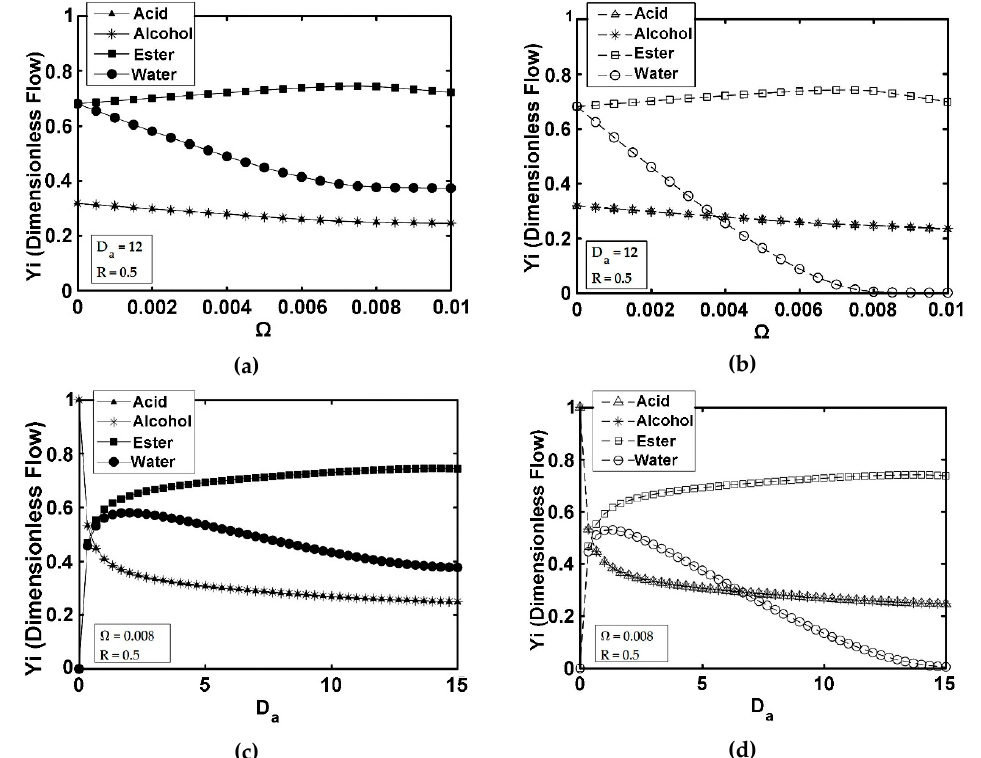
Figure 6. Outlet dimensionless species flows in the reactor (solid symbols) and in the pervaporator (symbols with no fill) when using a SR+PVMU, as a function of Ω ( a , b ) and D a ( c , d ). Notes: for ( a ), ( b ), ( c ), and ( d ) R = 0.5 and isoamyl alcohol and acid symbols superimpose each other given that the selected stochiometric ratio at feed conditions is 1.